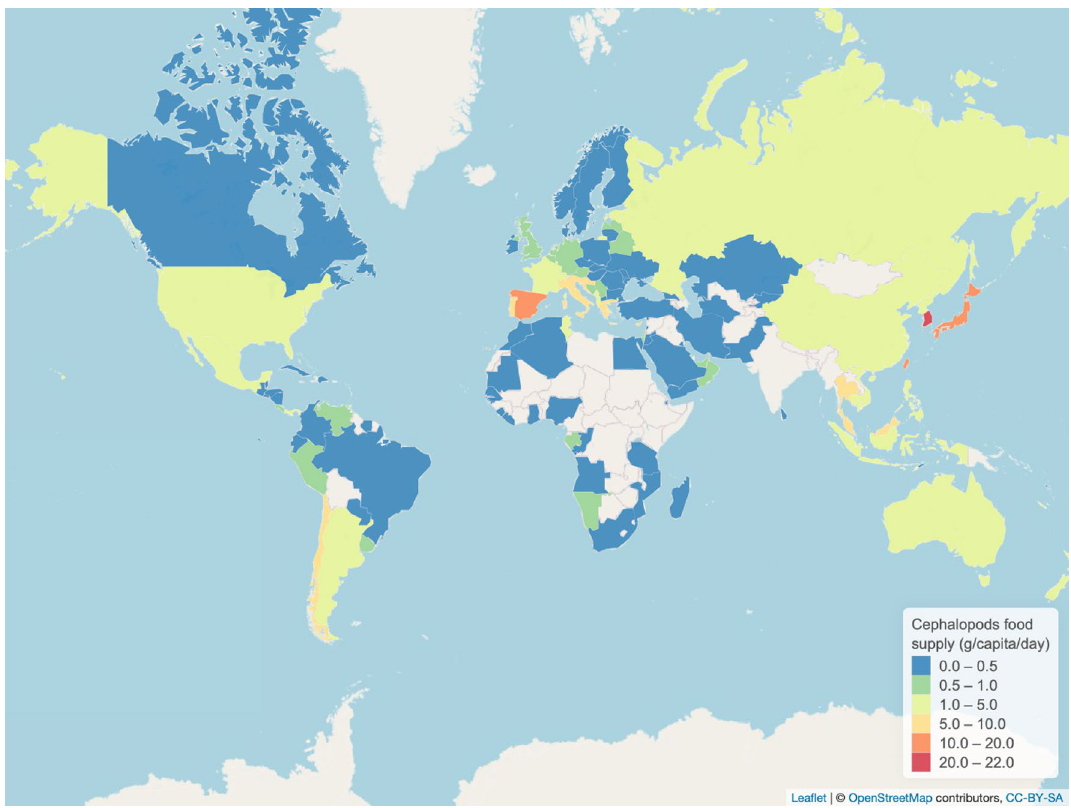
Figure 2. Worldwide cephalopod food supply in g/capita/day for 2013. Per capita supplies are only the average supply available for everyone in the country or territory population as a whole and do not show what is actually consumed by individuals. The figure was created with Leaflet (https:// leafl etjs. com) 14 for R 12 (https:// cran.r- proje ct. org) by using FAO cephalopod food supply data 8 and the continents layout from OpenStreetMap (https:// www. opens treet map.